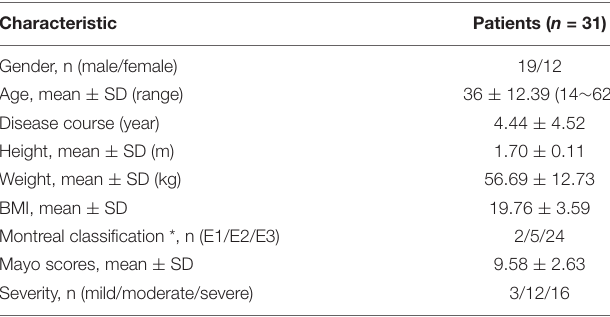
TABLE 1 | Baseline characteristics of enrolled UC